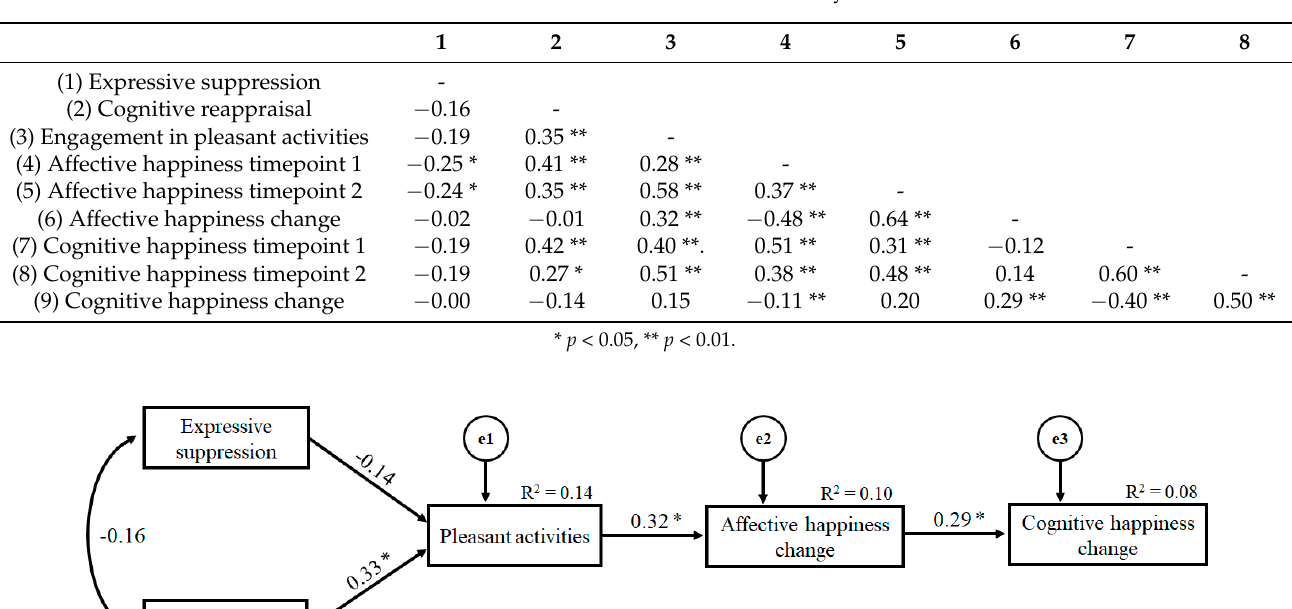
Table 2. Pearson’s correlation matrix for the study variables.